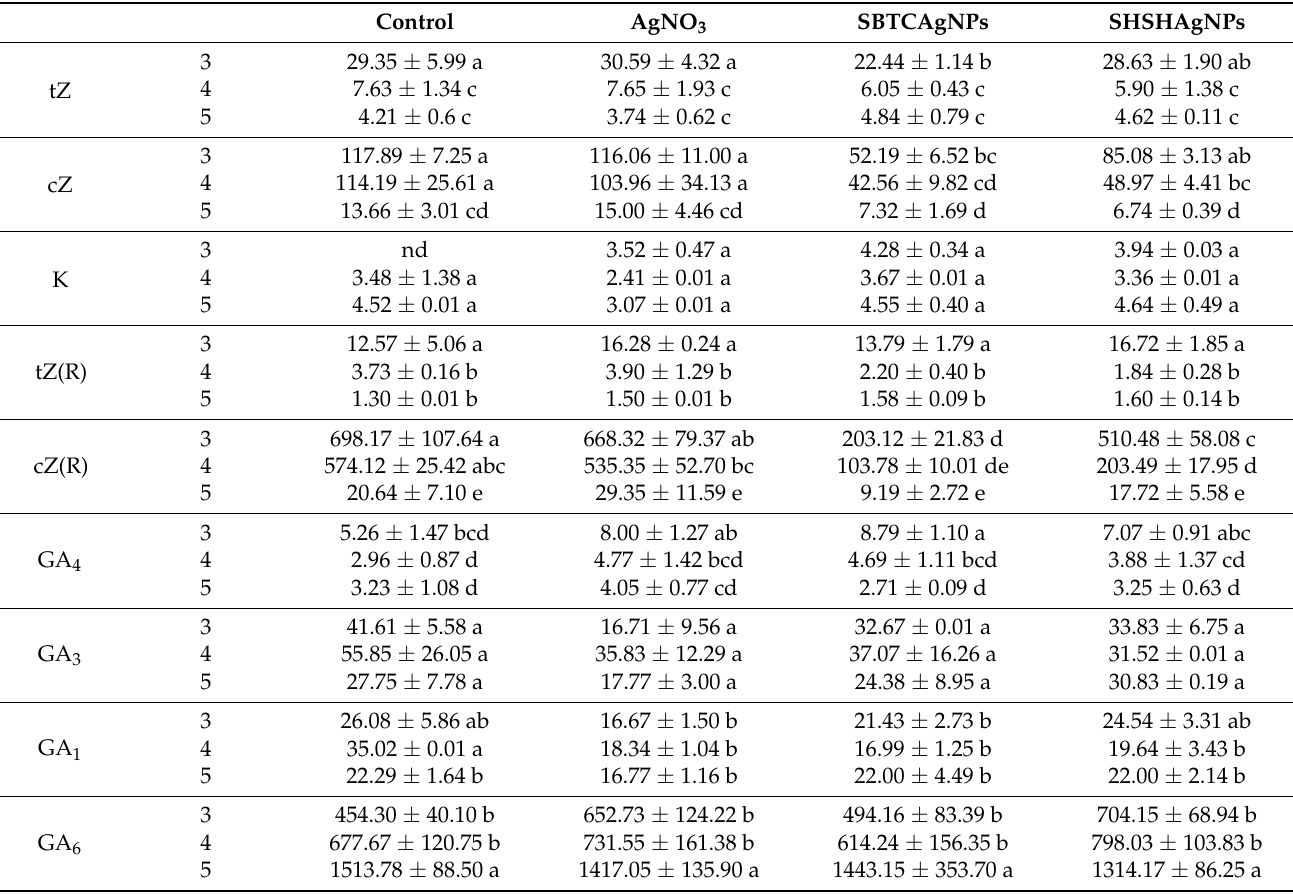
Figure 1. Growth in height of the control and the AgNO 3 -, SBTCAgNPs- and SHSHAgNPs-treated wheat plants from the 3rd to 7th week of growth ( A ). The percentage of wheat plants at vegetative and generative (heading) stages of development in control and the AgNO 3 -, SBTCAgNPs- and SHSHAgNPs-treated wheat plants at the 6th, 7th and 8th week of growth ( B ). Significant differences to the control within the term are given by asterisks: ** p < 0.01. Table 1. Endogenous phytohormone content (ng/g DW) in the leaves of the control and the AgNO 3 -, SBTCAgNPs- and SHSHAgNPs-treated wheat plants after 3, 4 and 5 weeks of growth. The presented data are the mean values based on 5 replicates ± SE. The mean values marked with the same letter within a parameter (phytohormone) did not differ significantly according to Duncan’s test, where p ≤ 0.05 (nd—not